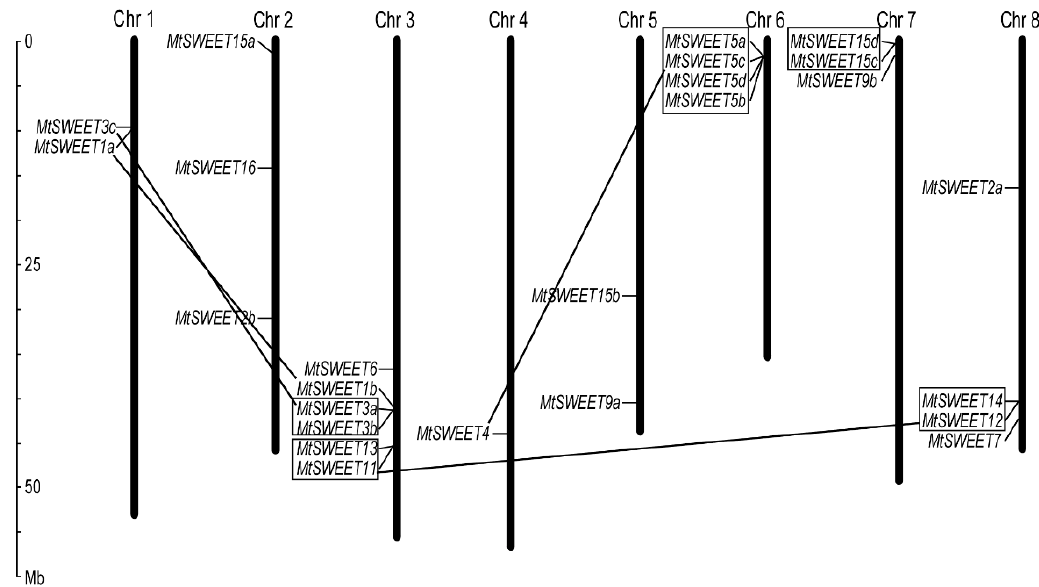
Figure 2. Locations and duplications of MtSWEET genes on M. truncatula chromosomes. The black lines indicate segmentally duplicated genes, and the tandemly duplicated genes are boxed. The scale is provided in megabase (Mb).